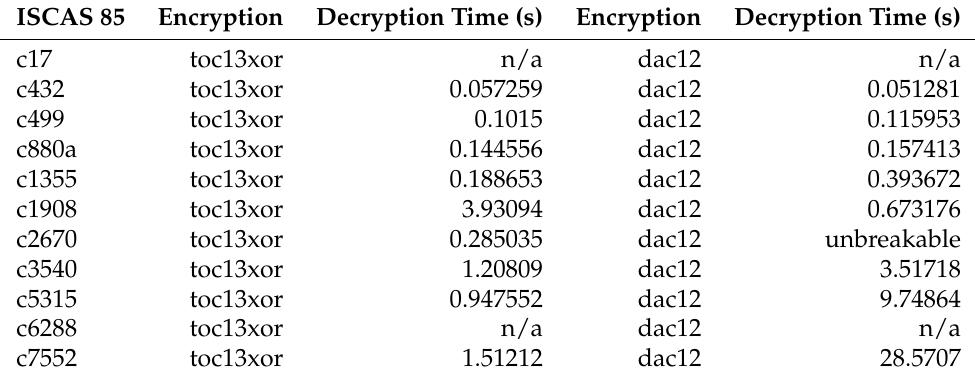
Table 5. ISCAS ’85 SAT Attack Results.